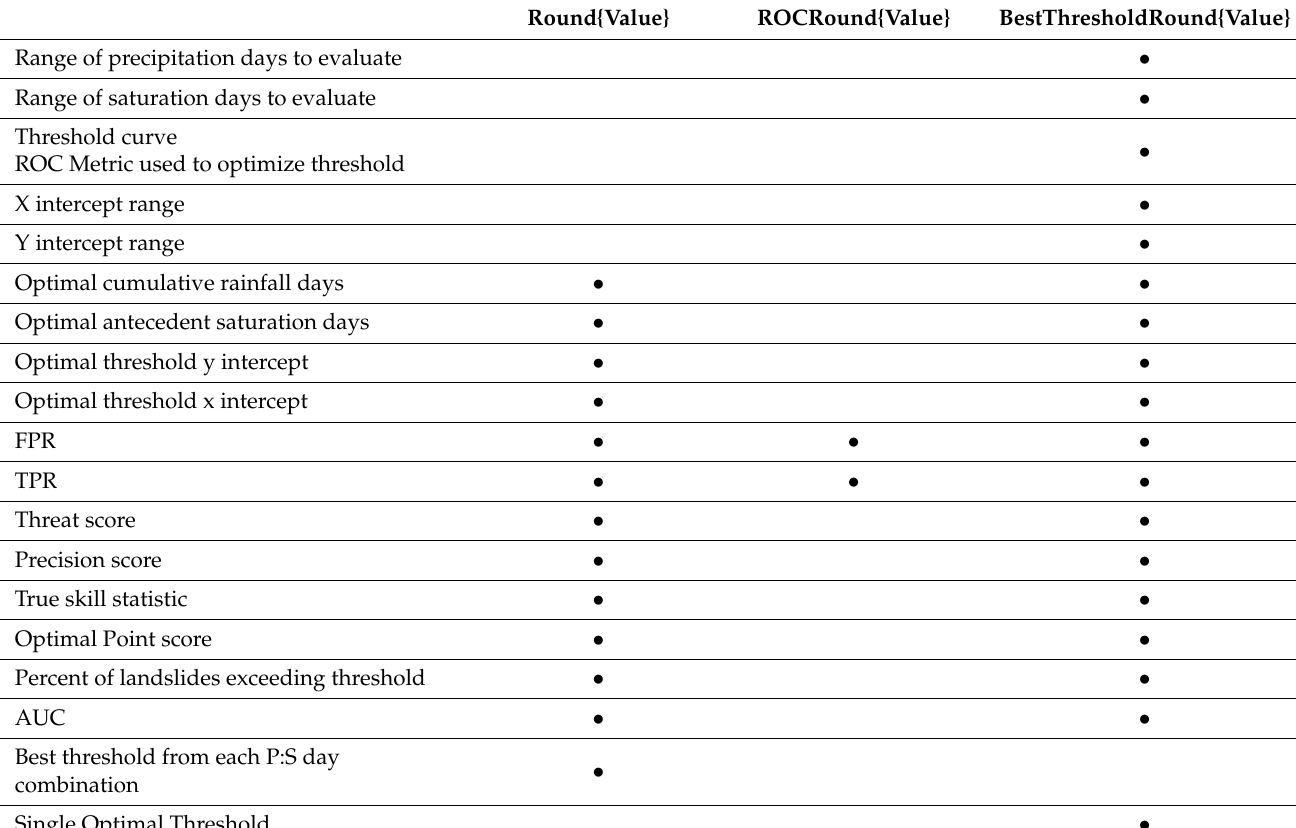
Table 2. The three output text files and contents are shown. The information contained has some intentional overlap. The main difference from Round{value} and BestThresholdRound{value} is that Round{value} shows the optimal threshold for each precipitation: saturation daily combination whereas BestThresholdRound{value} gives just the optimal threshold for the desired ROC metric and all possible variables used in the threshold analysis, not just the optimal threshold. Round{Value} ROCRound{Value} BestThresholdRound{Value} Range of precipitation days to